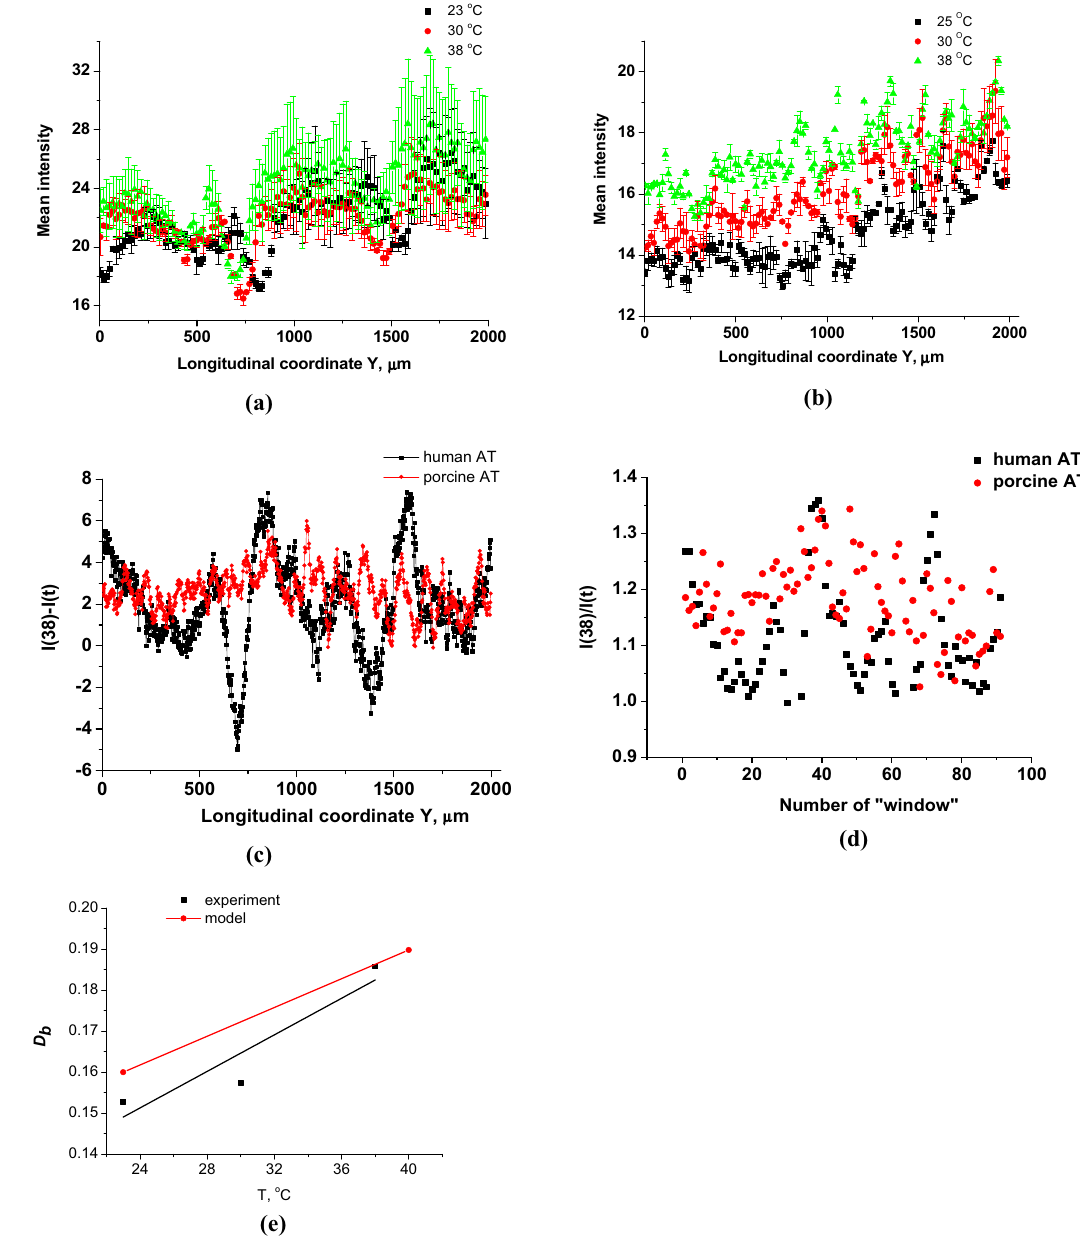
Figure 7. Results of statistical analysis for intensity of all light spots at the bottom of OCT image of the AT samples (see Fig. 7, the bottom surface of the sample image); the evolution with the temperature of these light spots intensity distributions for human ( a ) and porcine ( b ) fat tissue slices is shown. To recalculate the optical thickness into a geometric one, we took the average refractive index of AT equal to 1.44. ( c ) Distribution of difference in intensity at 38 °C and room temperature t of light spots at the bottom of OCT image of the AT samples, where t = 23 °C for human AT, and 25°C for porcine AT ( a , b , the bottom surface of the sample image). ( d ) Light spot intensity ratio I (38)/ I ( t ) distribution on the number of the averaging window of 20 μm in width counted from 0 to 2000 μm of the longitudinal coordinate of ( a , b ), where t = 23 °C for human AT, and 25 °C for porcine AT (see Fig. 7, the bottom surface of the sample image), and S-8b and S-8c. ( e ) The results of the D b calculation for AT model shown in Fig. S-4b and for experimental data presented in ( a In vivo microscopy of AT. In In vivo transmission images of rat abdominal AT for the cell layer thickness of 120 ± 15 μm, in the initial state at room temperature (25 °C) (a) and after heating up to 30 °C (b) and 38 °C (c), are presented in Fig. 8. When heated, the transmission of a layer of AT for red light increases, while for white and green light it decreases, and for green it is not as strong as for white. Red light from a laser is weakly absorbed by living tissue, since its wavelength lies at a sufficient distance from the main absorption bands of hemoglobin, and therefore